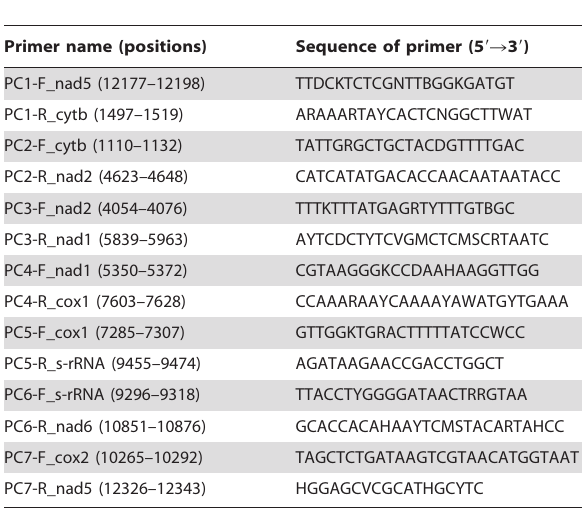
Table 1. Primers for amplification of mt DNA genome of P . cervi